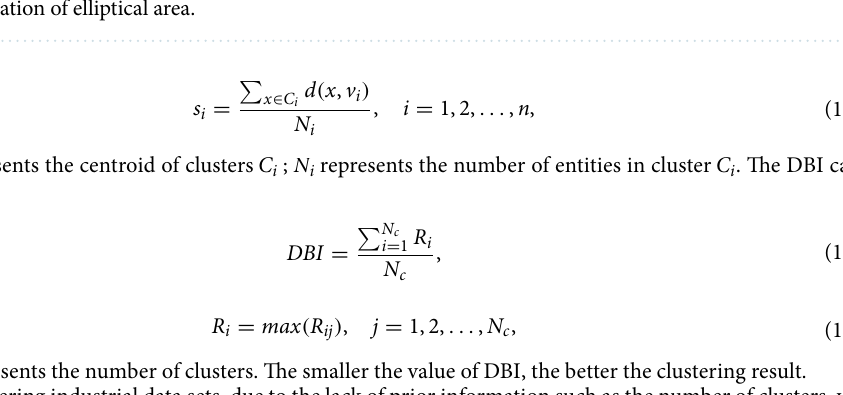
Figure 2. Initialization and termination of a sequence: initialize by elliptical density and select candidate clusters by mutation of elliptical